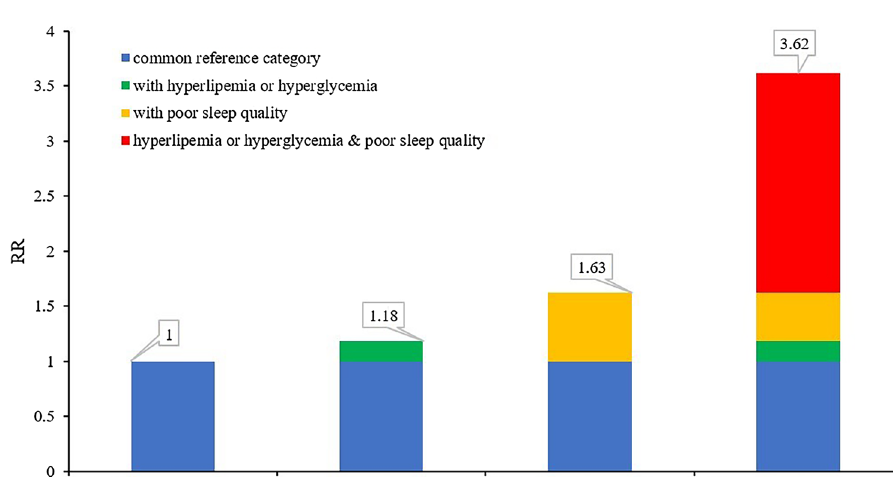
Figure 3. An additive effect of PSQI and hyperlipemia/hyperglycemia for females ≥